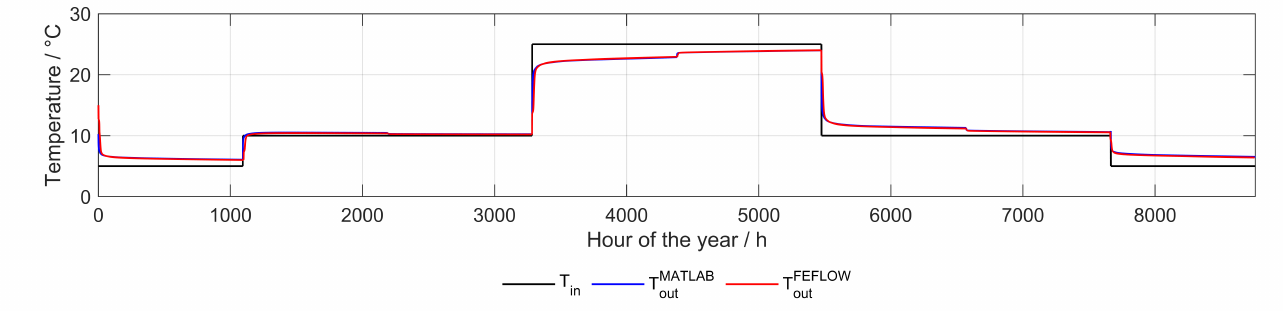
Figure 8. Inlet Temperature and simulated mean outlet temperatures of the 349 in parallel connected probes within the